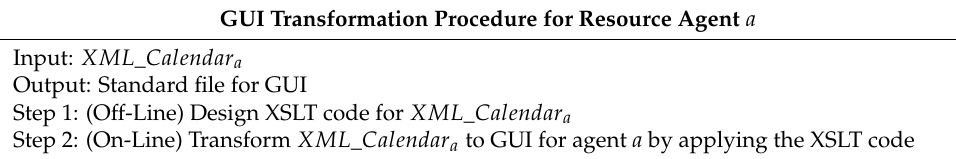
Table 2. GUI Transformation Procedure for Resource Agent. GUI Transformation Procedure for Resource Agent a